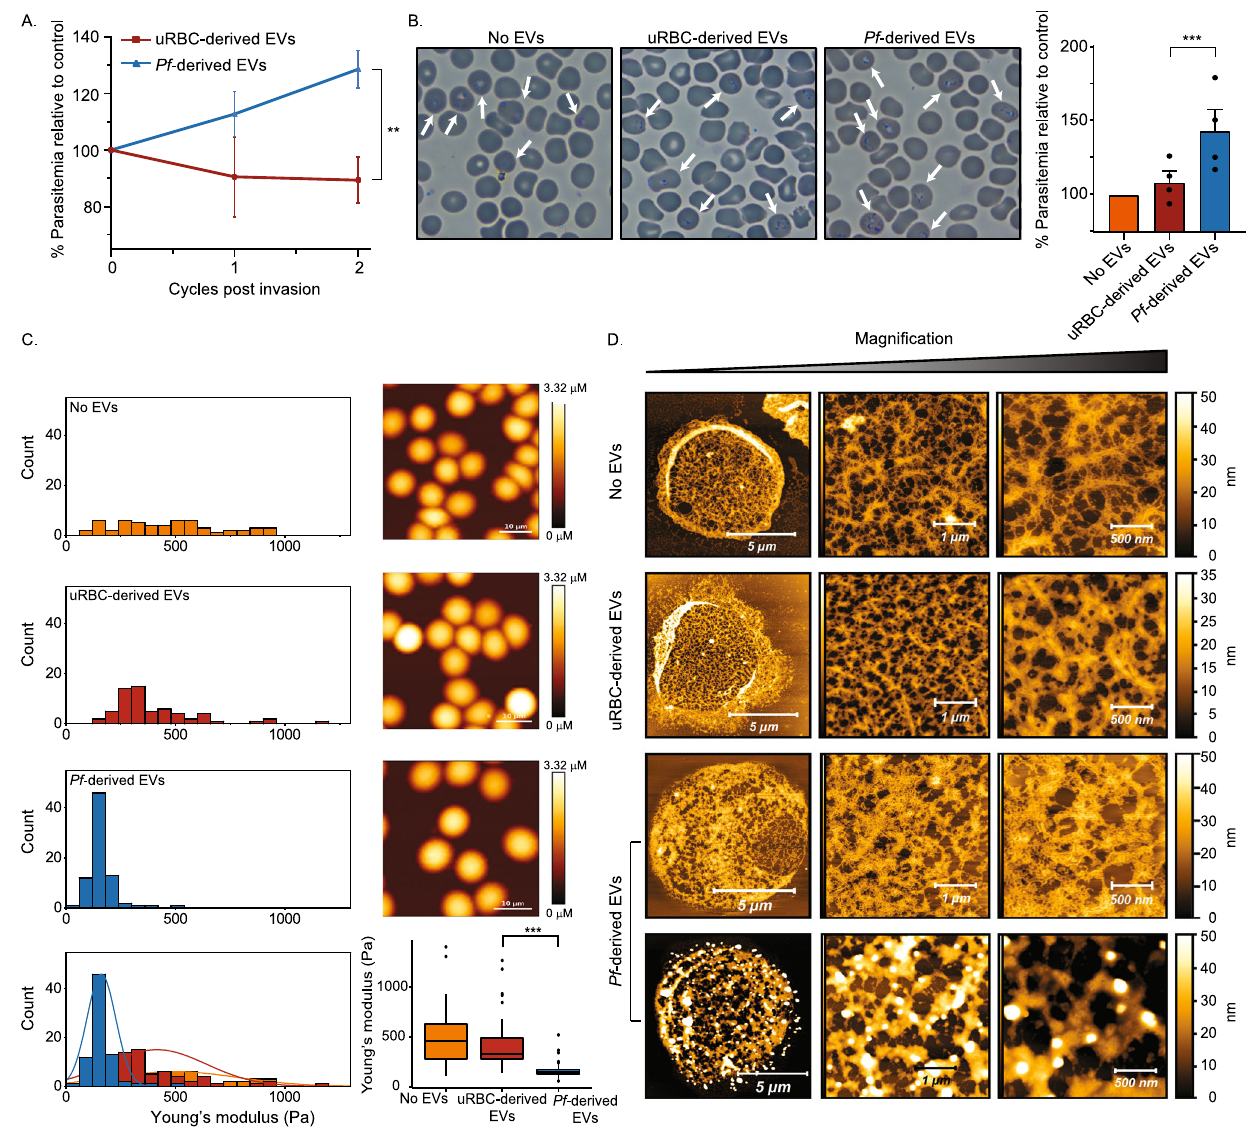
Fig. 1 Pf -derived EV treatment in fl uences growth dynamics and morphology of naïve RBCs. A , B Pf -derived EVs were incubated for 18 hr with naïve RBCs. Magnet-puri fi ed Pf were then introduced to the treated cells and the parasitemia level was monitored (estimated comparing to the untreated control) using fl ow cytometry ( A ) and Giemsa smears ( B ). Treatment with uRBC-derived EVs or the absence of EVs were used as controls. A Averages and statistical signi fi cance for at least three independent experiments were calculated by comparing percentages (relative to control) between treatments with a 2-way ANOVA, accounting for treatment and batch (uRBC-derived EVs 1st cycle n = 3, Pf -derived EVs 1st cycle n = 9, uRBC-derived EVs 2nd cycle n = 4, Pf -derived EVs 2nd cycle n = 12, ** p = 0.00416). Error bars represent SEM (standard error of the mean). B The arrows indicate Pf- iRBCs. Scale bars represent 10 μ m. Averages and statistical analysis of four independent experiments, in which counts were compared between treatments using a mixed GLM, assuming a binomial distribution, with a random intercept for batch (*** p = 0.0008). Error bars represent SEM. C Mechanical changes of the recipient naïve RBCs following the Pf -derived EV treatment. Distributions of Young ’ s modulus values were obtained from AFM measurements (left panel), each count in the histogram represents the average value calculated from 25 indentations near the center of each cell. AFM images of the EV-treated and -untreated RBCs are shown on the right panel (scale bar 10 µ m). Differences between groups shown in the box plot were tested with a one-way ANOVA, followed by Tukey ’ s post-hoc test. Boxes represent the 25-75 percentiles of the sample distribution, with black vertical lines representing the 1.5×IQR (interquartile range). The black dots represent outliers. Black horizontal line represents the median. Log-transformed data was used due to the mean- variance correlation. Three independent experiments, each comparing naïve RBCs, uRBC-derived EV and Pf -derived EV exposure, were performed with total of 15 full images acquired for each of the cell exposure conditions. Number of cells measured were for No EVs n = 57, uRBC-derived EVs n = 63, Pf - derived EVs n = 77, *** p < 0.001). D Representative AFM images of cytoskeletal structures of naïve RBCs, naïve RBCs incubated with either uRBC-derived or Pf -derived EVs. The sharp fi brilar network assigned to spectrin fi laments seen in the upper frames breaks down and becomes blurred and disconnected in the lower frames. Three independent experiments were performed, with a total of 50 AFM scans for each type of cell treatment. A – D Results are representative of at least three independent biological replicates. Source data for A and B are provided in Supplementary Fig. S2.